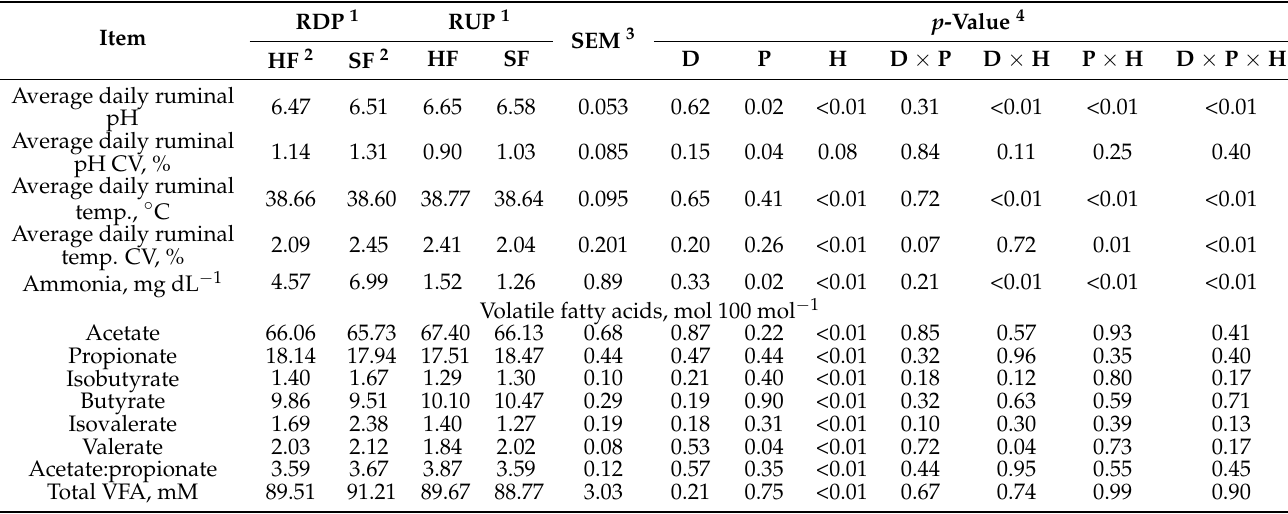
Table 5. Impacts of supplement deliver method, protein type, and hour on ruminal pH and VFA concentrations in 2- and 3-year-old beef cows fed low-quality